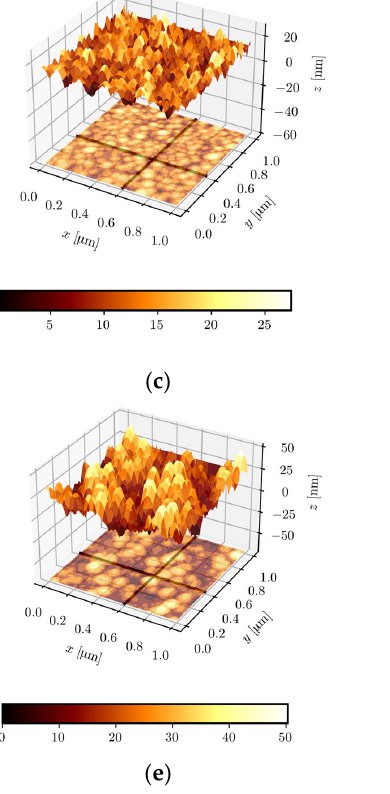
Figure 11. AFM images and corresponding line profiles for ZnO-2 ( a , b ), ZnO-30 ( c , d ), and ZnO-64 ( e , f ) films.